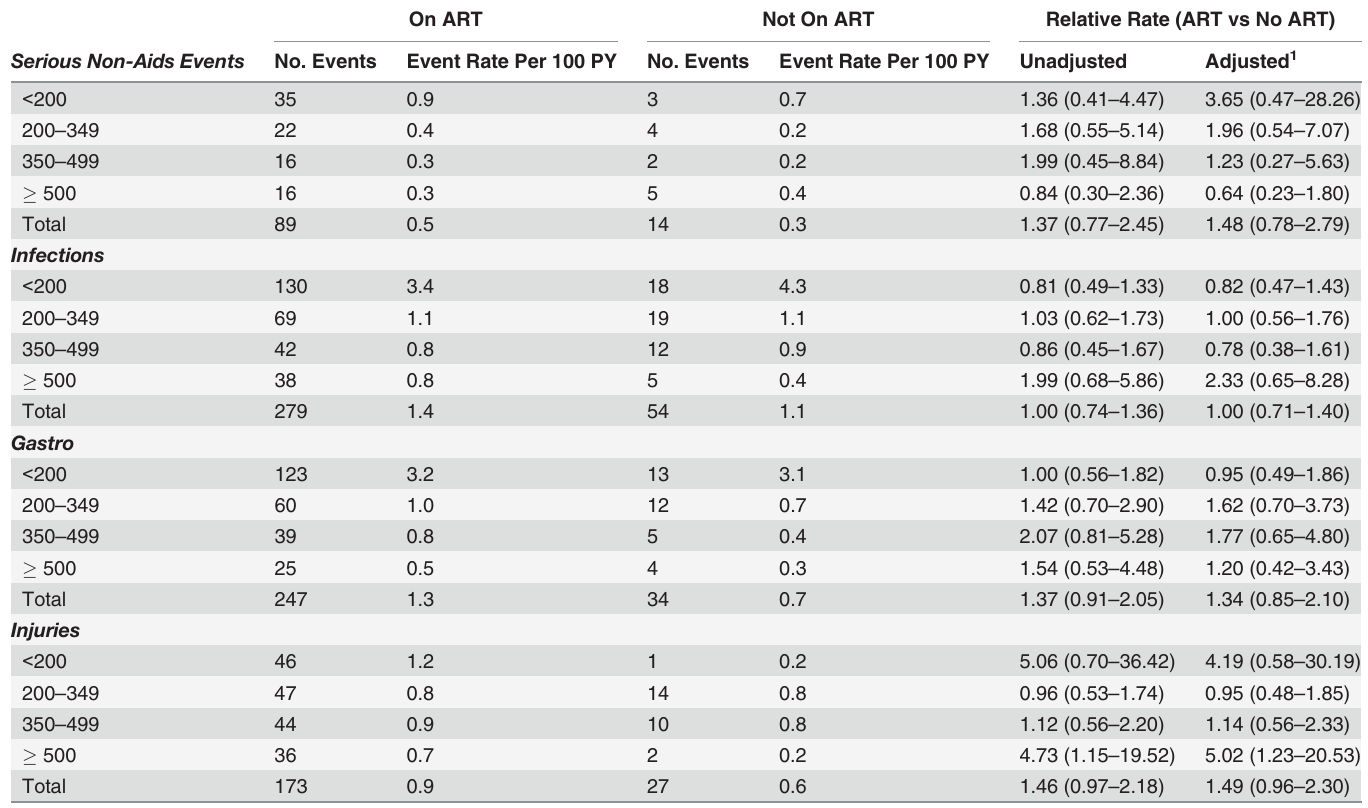
Table 6. Grade 4 Event Types by Latest CD4 Count (cells/mm 3 ) and ART Status: Morbidity and Mortality